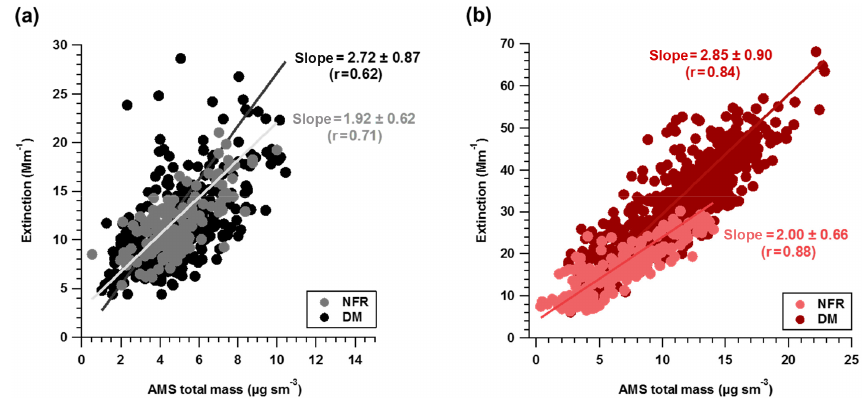
Figure 14. Mass extinction efficiency plots of β ext against total NR-PM 1 mass for NFR and DM during (a) non-cyclone and (b) cyclone episodes. Inferred slopes are derived from ODR error-weighted (10% β ext , 30% mAMS total mass)